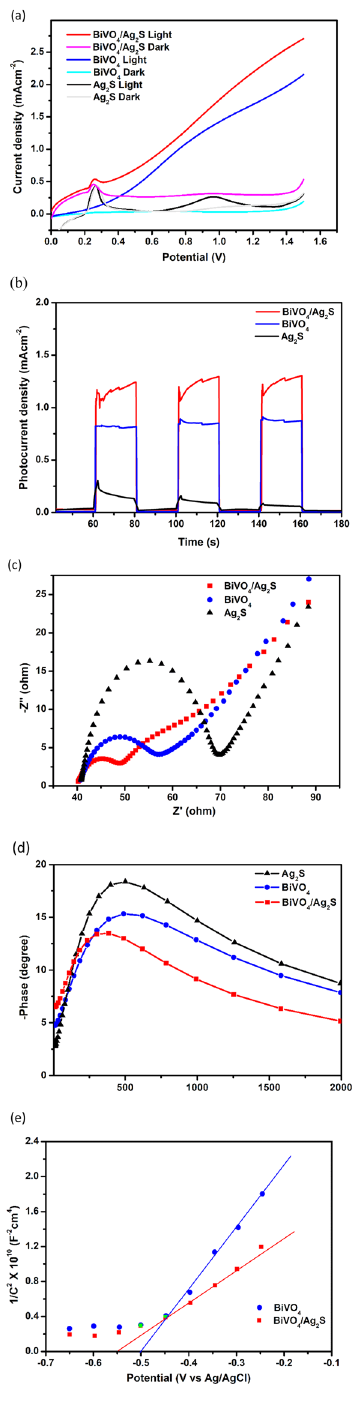
Figure 4. ( a ) Linear sweep voltammogram at 20 mVs − 1 ; ( b ) photocurrent response in 0.1 M Na 2 SO 4 ; ( c ) Nyquist EIS plot; ( d ) Bode plot and ( e ) Mott Shottky plot for Ag 2 S, BiVO 4 and BiVO 4 /Ag 2 S photoanodes in 5 mM [Fe(CN) 6 ] 3 − /4 − in 0.1 M KCl (pH